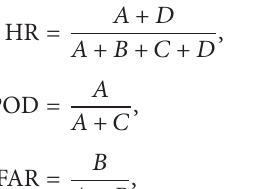
Table 2: Two-dimensional (2 × 2) contingency table. Forecast Observation Frost No frost